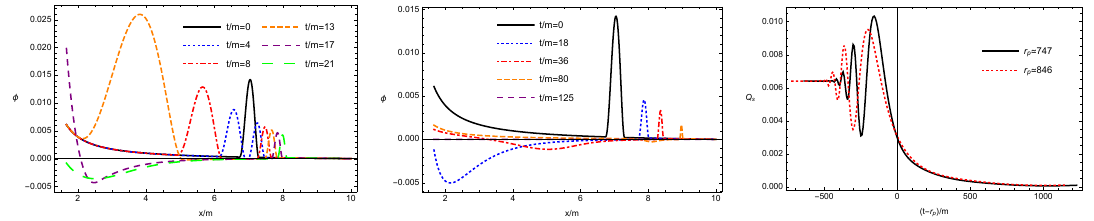
Figure 11 . The evolution of the scalar field. Left and Middle: the profiles of the scalar field, calculated at different time instants. Right: the scalar charge Q s as a function of ( t evaluated at r p = 747 and 846,